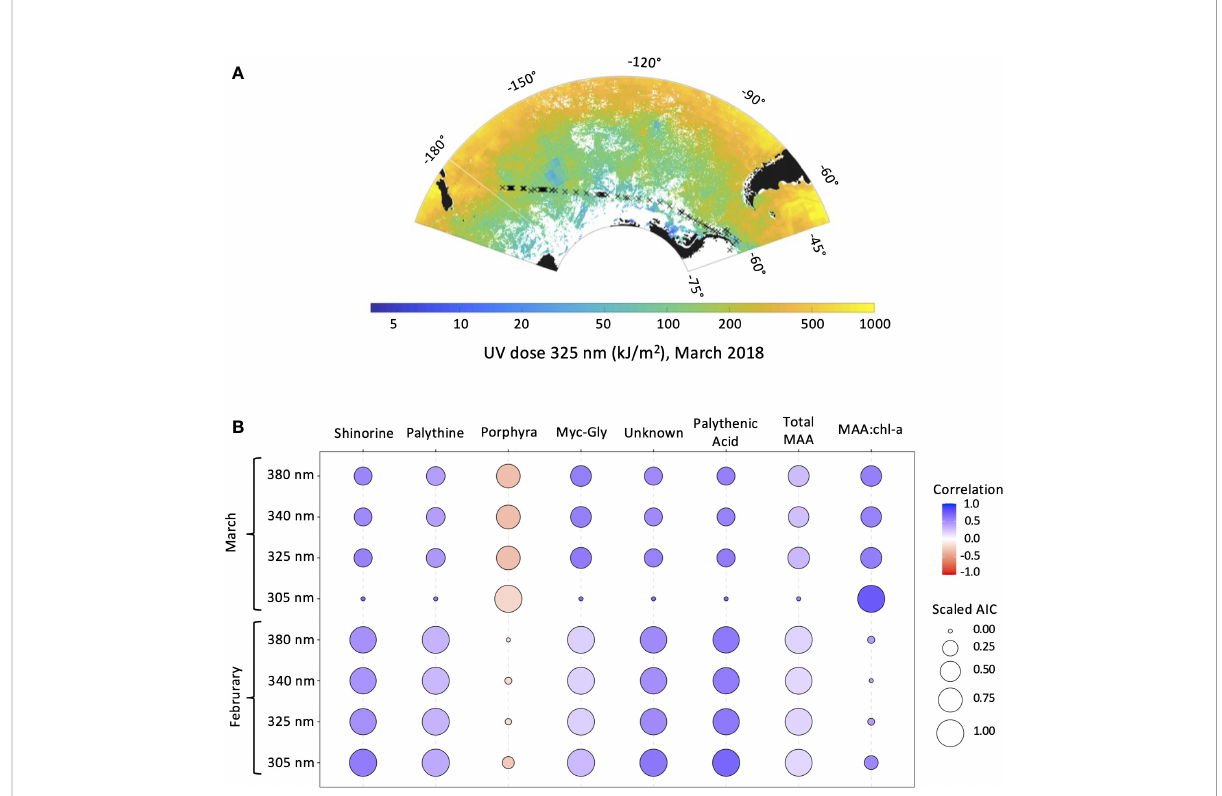
FIGURE 7 (A) Modeled UVR dosage at 325 nm for March 2018 overlaid on cruise transect map. (B) Pearson correlation coef fi cient and scaled Akaike information criterion (AIC) between UVR dosage at 305, 325, 340, and 380 nm in February and March 2018, and MAA fractions, total MAAs, and